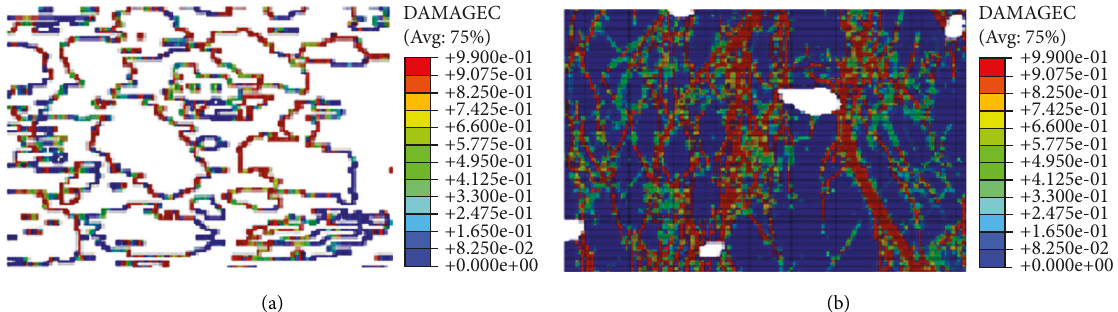
Figure 18: Local failure graph of material. (a) Interface. (b)